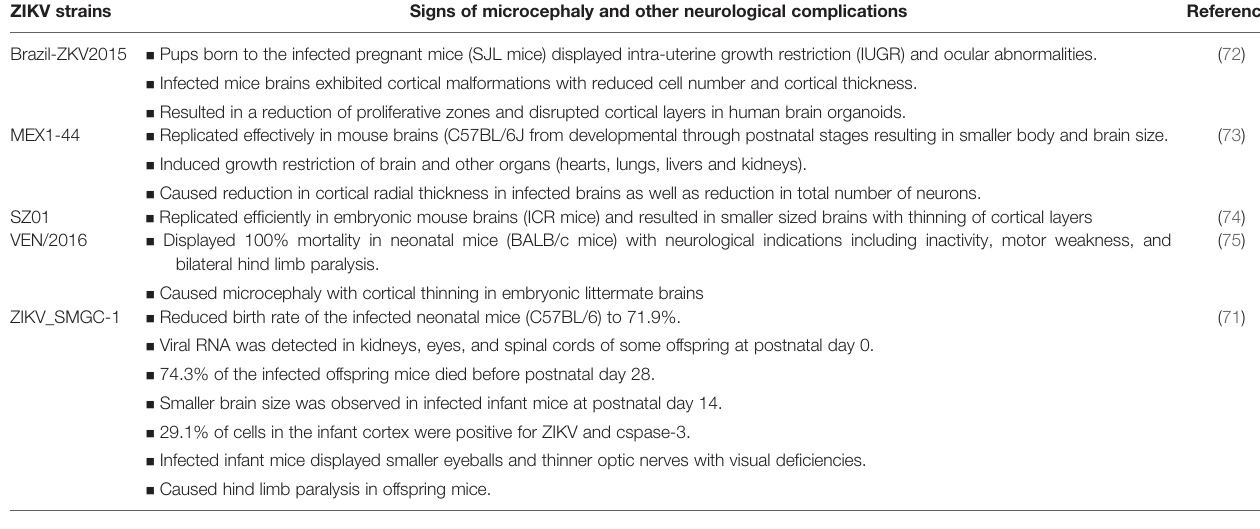
TABLE 4 | Mouse models for ZIKV neuropathogenesis. Model strain